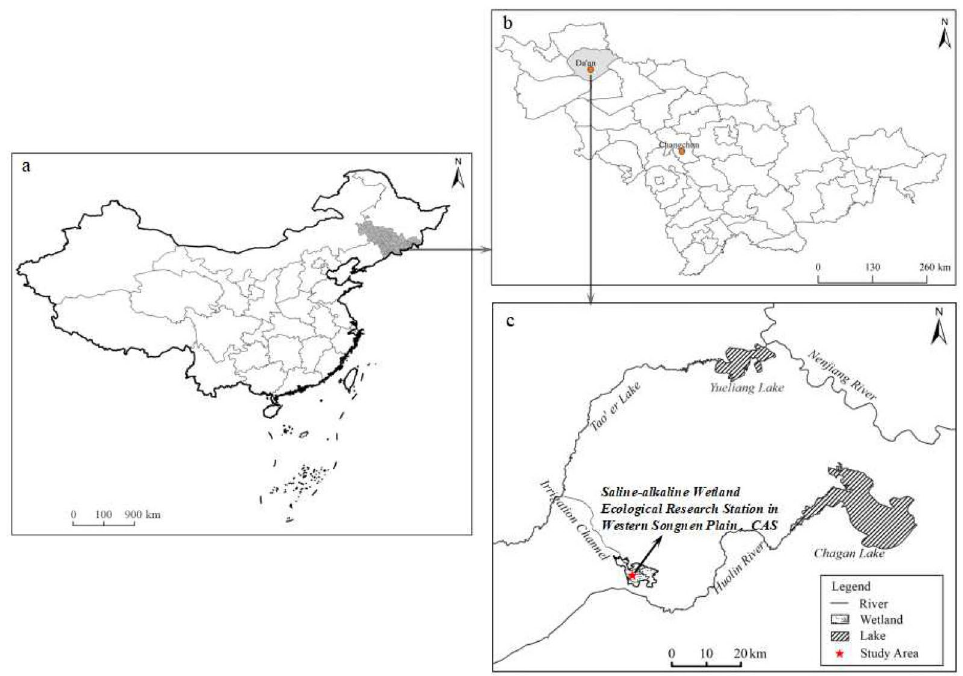
Figure 1. Map of region and study area. Location map of China (a). Location map of Songnen Plain, China (b). Location map of the study area in Western Songnen Plain in Northeast China (c). This map was generated by ArcGIS 10.2 (http://www.arcgi s.com/featu res/index .html).